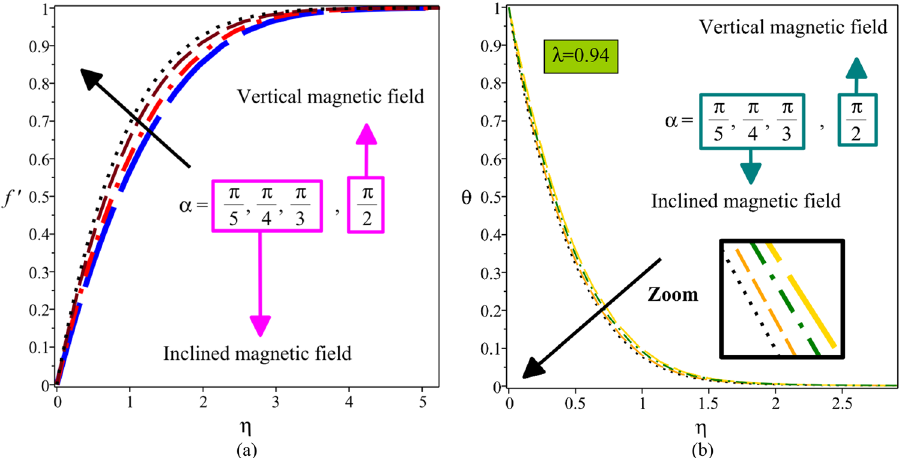
Figure 5. Velocity profile ( a ) and temperature distribution ( b ) for different values of α .